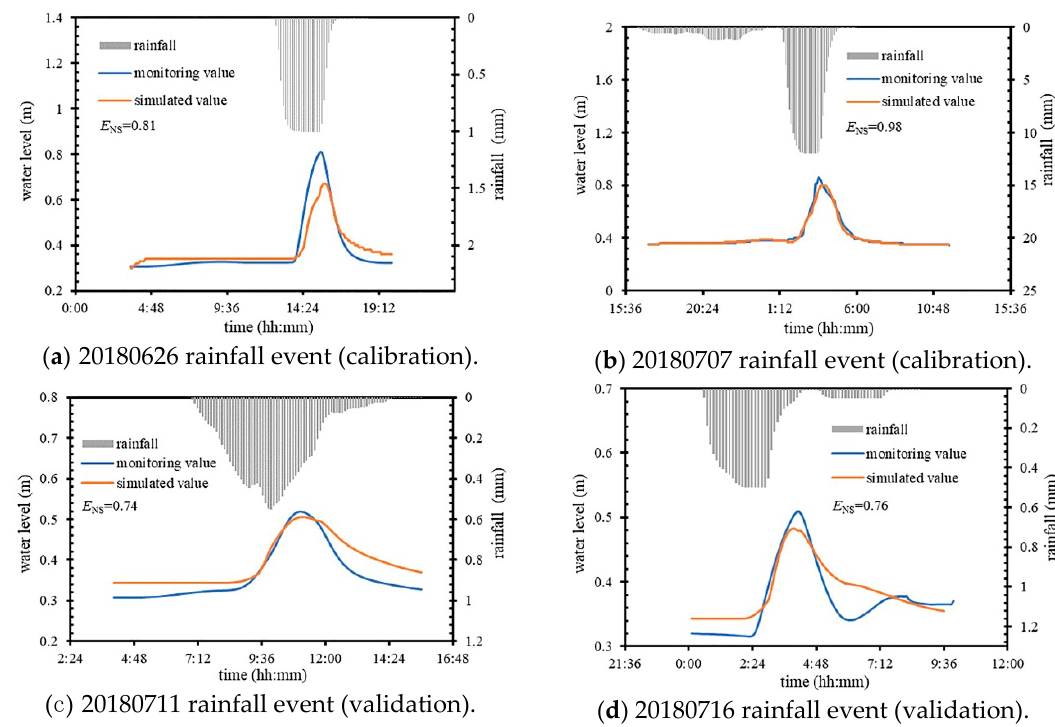
Figure 2. Calibration and validation of model parameters in the study area (the E NS is used to determine the accuracy of the simulation results of the hydrological model).